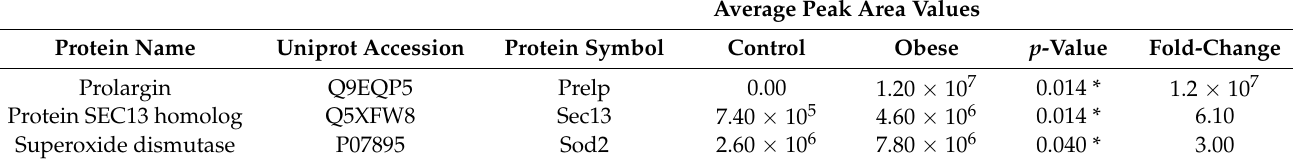
Table 1. List of differentially abundant proteins related to obesity in the GO term “extracellular exosome” in the PDL of control and obese groups. Average peak area values of each group, p -values ( t -test) and fold-change are shown. Extracellular Exosome